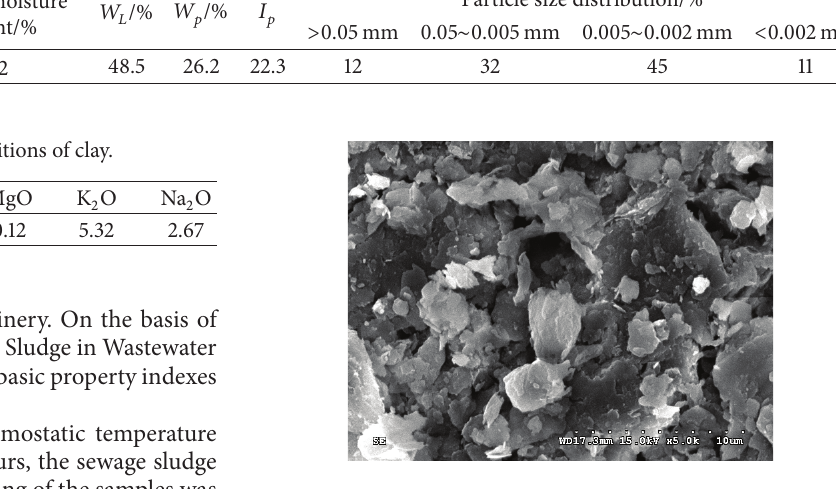
Figure 1: The microstructure of SSA.